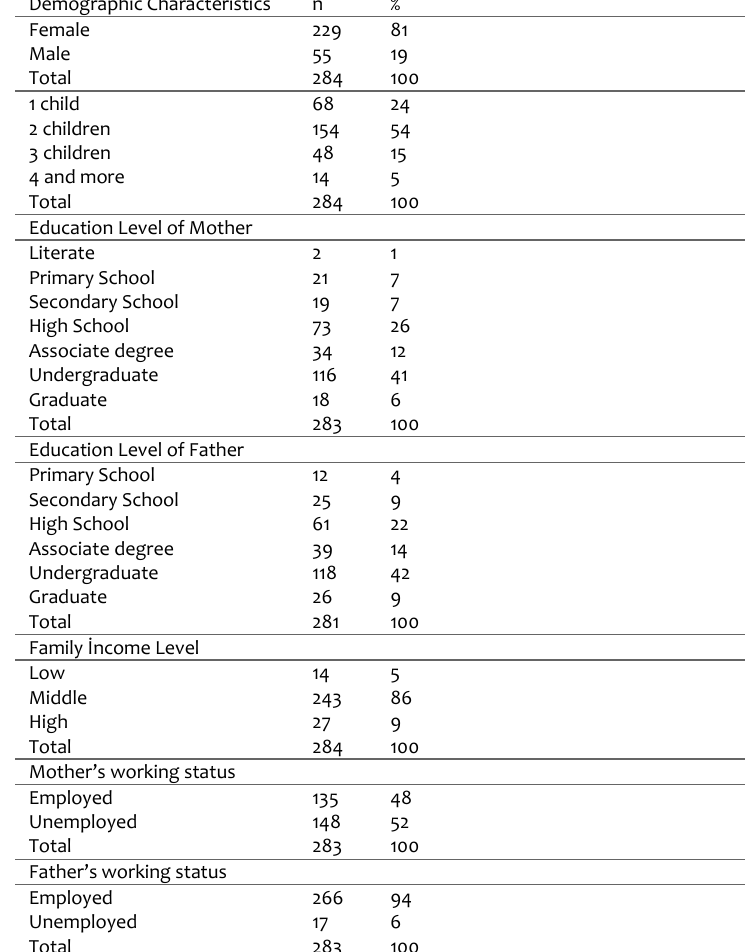
Table 2. Distribution of Demographic Characteristics of the Parents of Children Participating in the